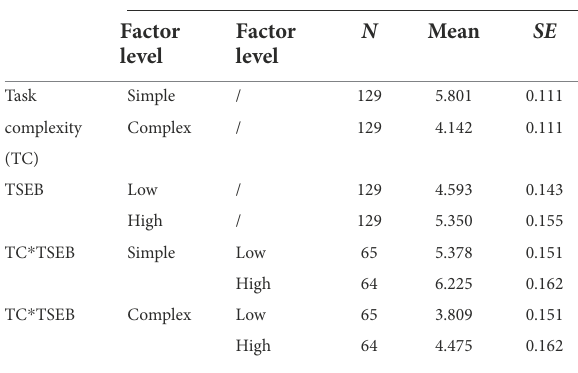
TABLE 7 Fluency—significant effects of task complexity and